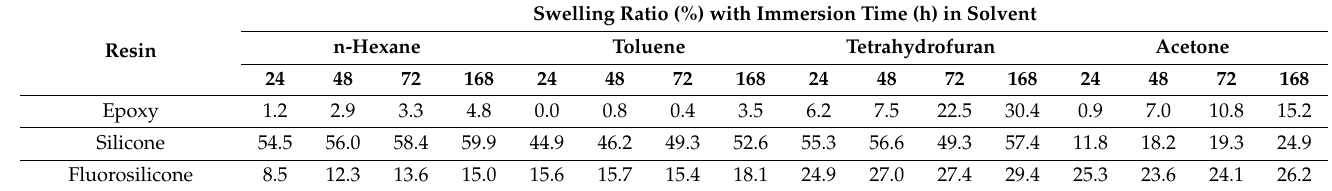
Table 3. The swelling ratio of epoxy, silicone, and fluorosilicone resins in various solvents.